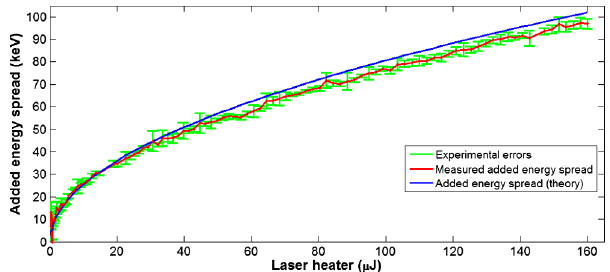
FIG. 6. Laser heater induced rms slice energy spread, theo- retical (solid line) and experimental (dots), as a function of the laser energy per